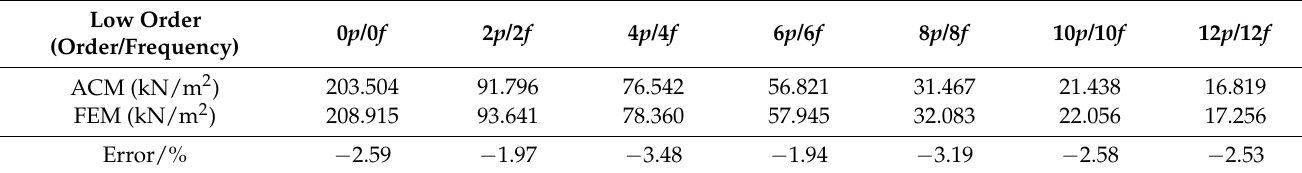
Table 6. Main low-order no-load radial force density.